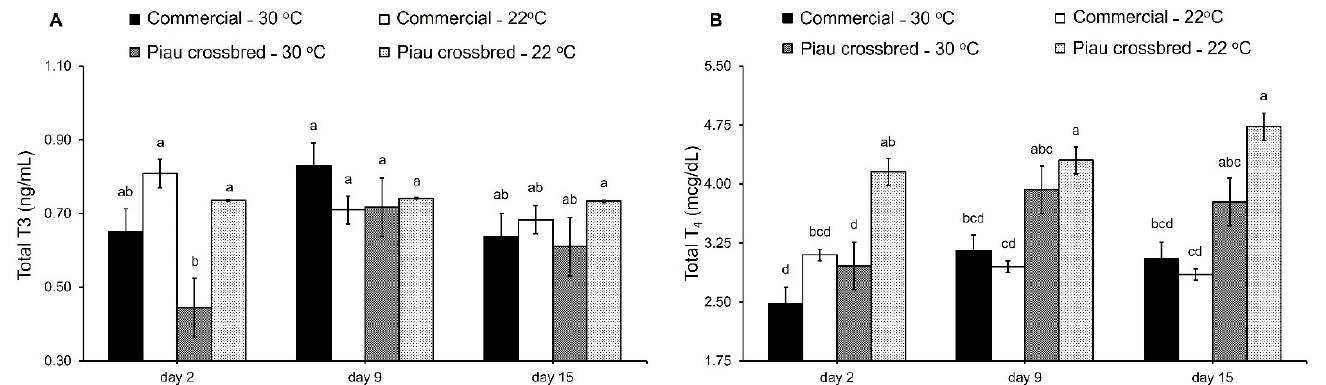
1 Residual Standard Deviation. 2 The observed interaction ( p < 0.05) between Gen × Temp × Day for T 3 and T 4 circulating levels are presented in Figure 2. 3 Breaths per minute.